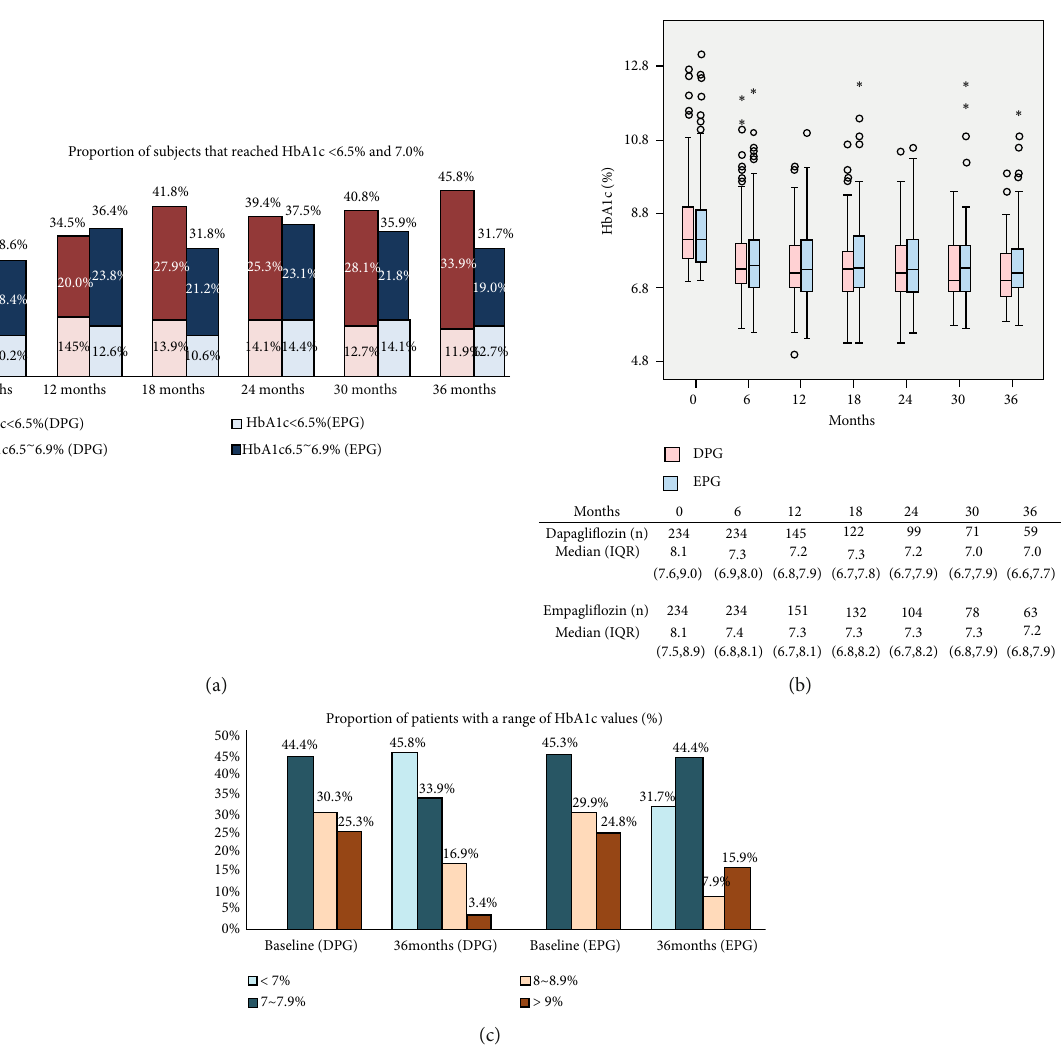
Figure 2: Long-term tracking of HbA1c-related data; HbA1c: hemoglobin A1c; DPG: dapagli fl ozin; EPG: empagli fl ozin. (a) Proportion of subjects that reached HbA1c < 6.5% (DPG), HbA1c 6.5 ~ 6.9% (DPG), HbA1c < 6.5% (EPG), and HbA1c 6.5 ~ 6.9% (EPG) at 6, 12, 18, 24, 30, and 36 months. (b) Box plots indicating the HbA1c values compared to baseline levels after 6, 12, 18, 24, 30, and 36 months of treatment. (c) Proportion of subjects with a range of HbA1c values at 0 and 36 months. Range of HbA1c values by bars: < 7.0%, 7% ~ 7.9%, 8% ~ 8.9%, >